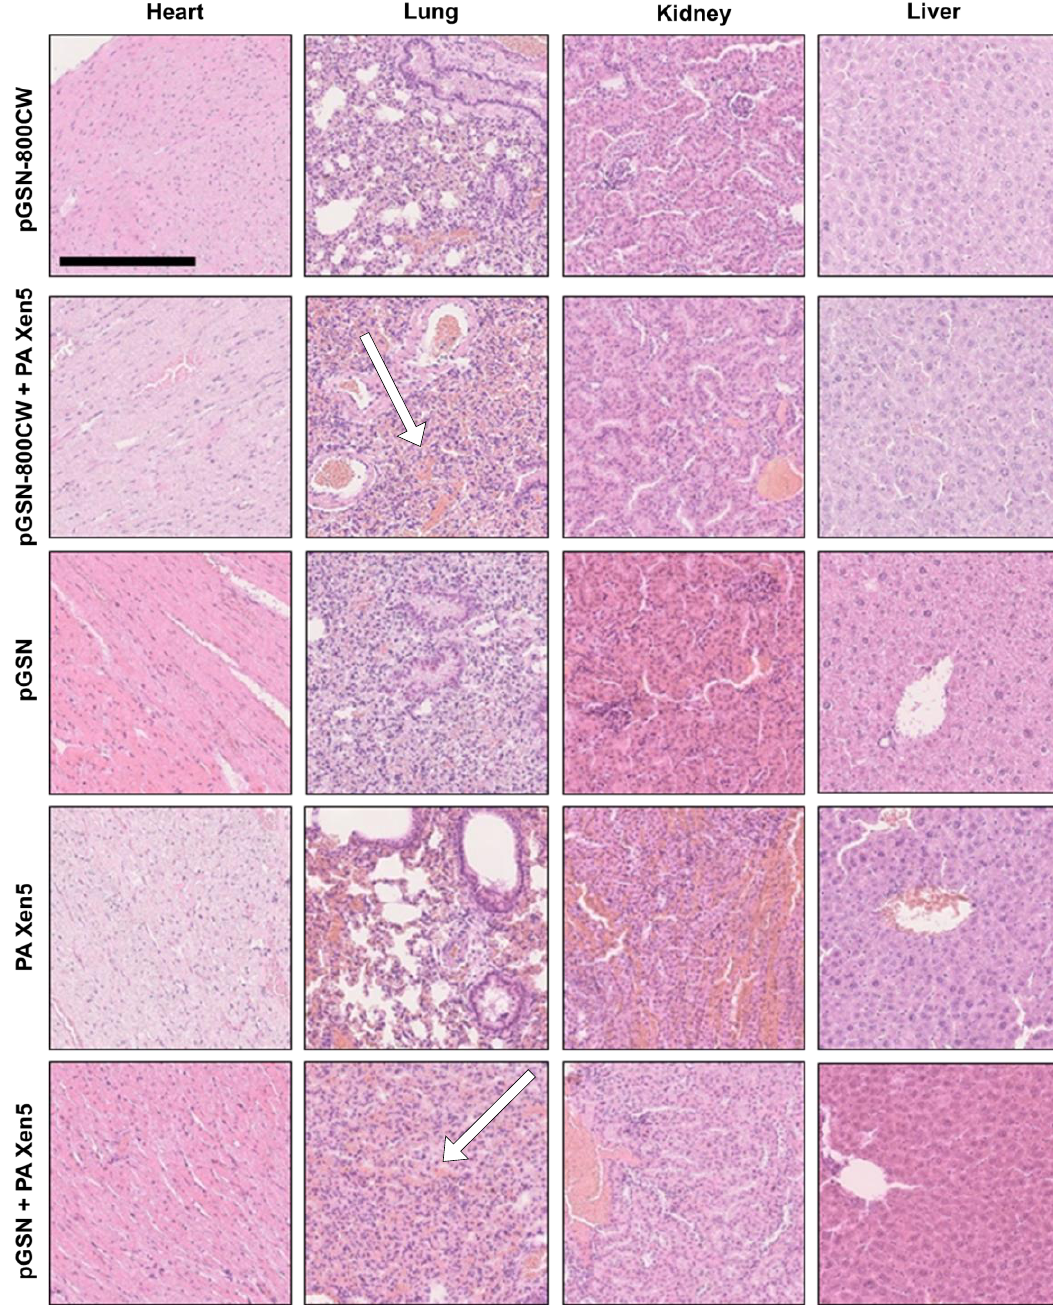
Figure 4. Histological analysis of the main organs of Cby.Cg-Foxn1nu / cmdb mice. Hematoxylin-eosin staining was performed to examine histopathological changes (200 × ). Lung injury was characterized by accumulation of blood (white arrows). Black scale bar indicates 250 µ m. Results from one representative experiment are shown.